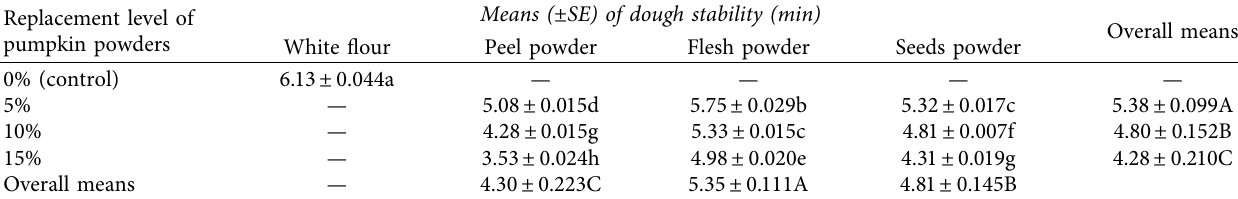
Table 3: Dough stability (min) of biscuits with diferent replacement levels of pumpkin peel, fesh, and seed powders. Replacement level of pumpkin powders